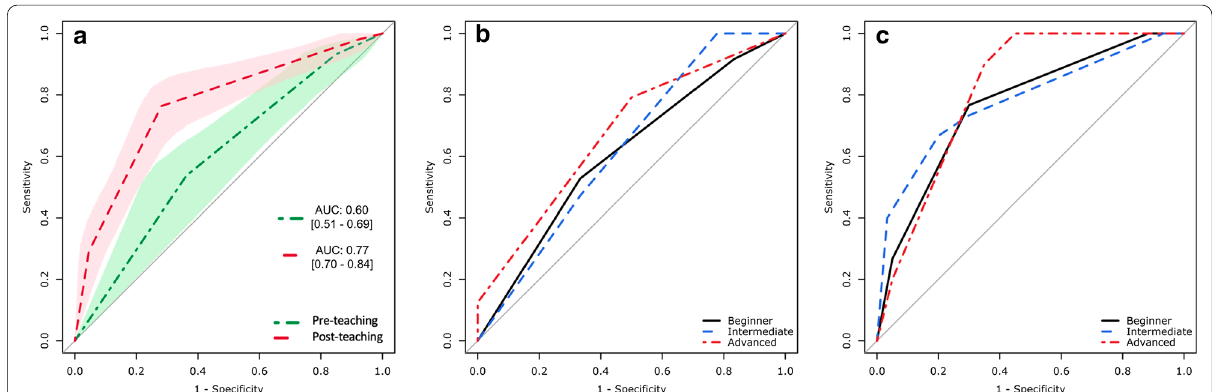
Fig. 6 Average area under the curve (AUC) for the detection of radiological change in the pre‑teaching (red, dash‑dotted line) and post‑teaching (green, dashed line) cohorts, with shaded areas and square brackets representing the 95% confidence intervals ( a ). AUCs for the detection of radiological change stratified by reader experience (as reported in Table 3) before ( b ) and after teaching ( c )